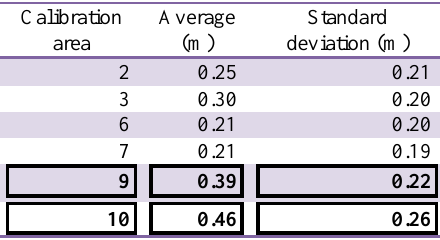
Table 3: Averages and standard deviations of the